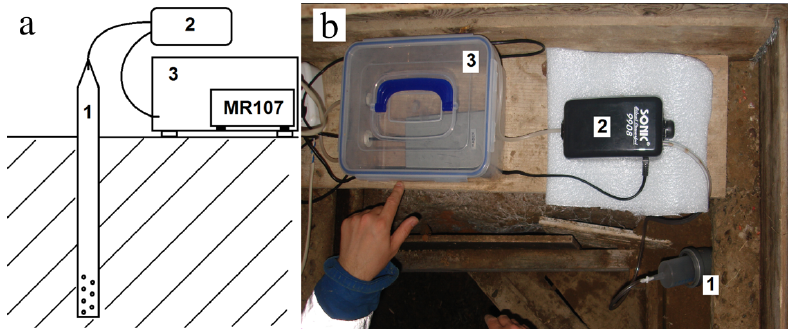
Figure 1. Block diagram ( a ) and general view ( b ) of the subsoil radon registration kit: ( 1 ) perforated pipe in a borehole; ( 2 ) compressor; ( 3 ) accumulation chamber with the MR107 device.